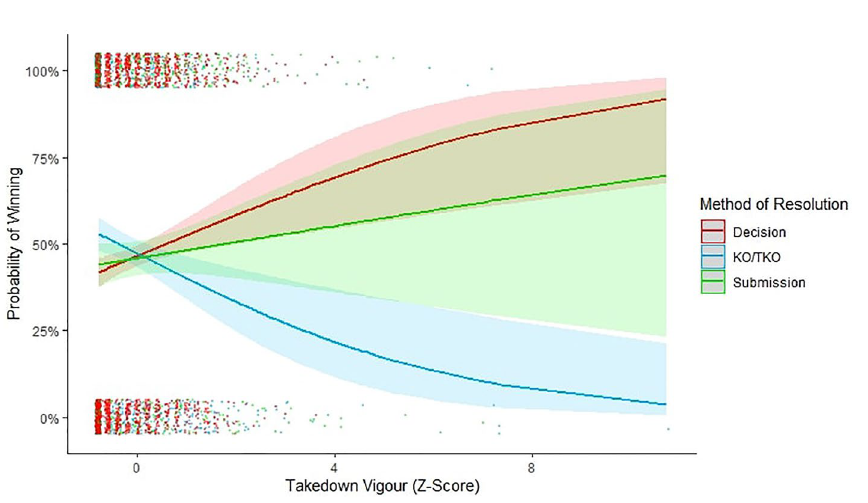
Figure 4. The interaction between grappling vigour and the method of resolution on likelihood of winning. Error bands illustrate 95% confidence intervals. Data points are jittered for visibility